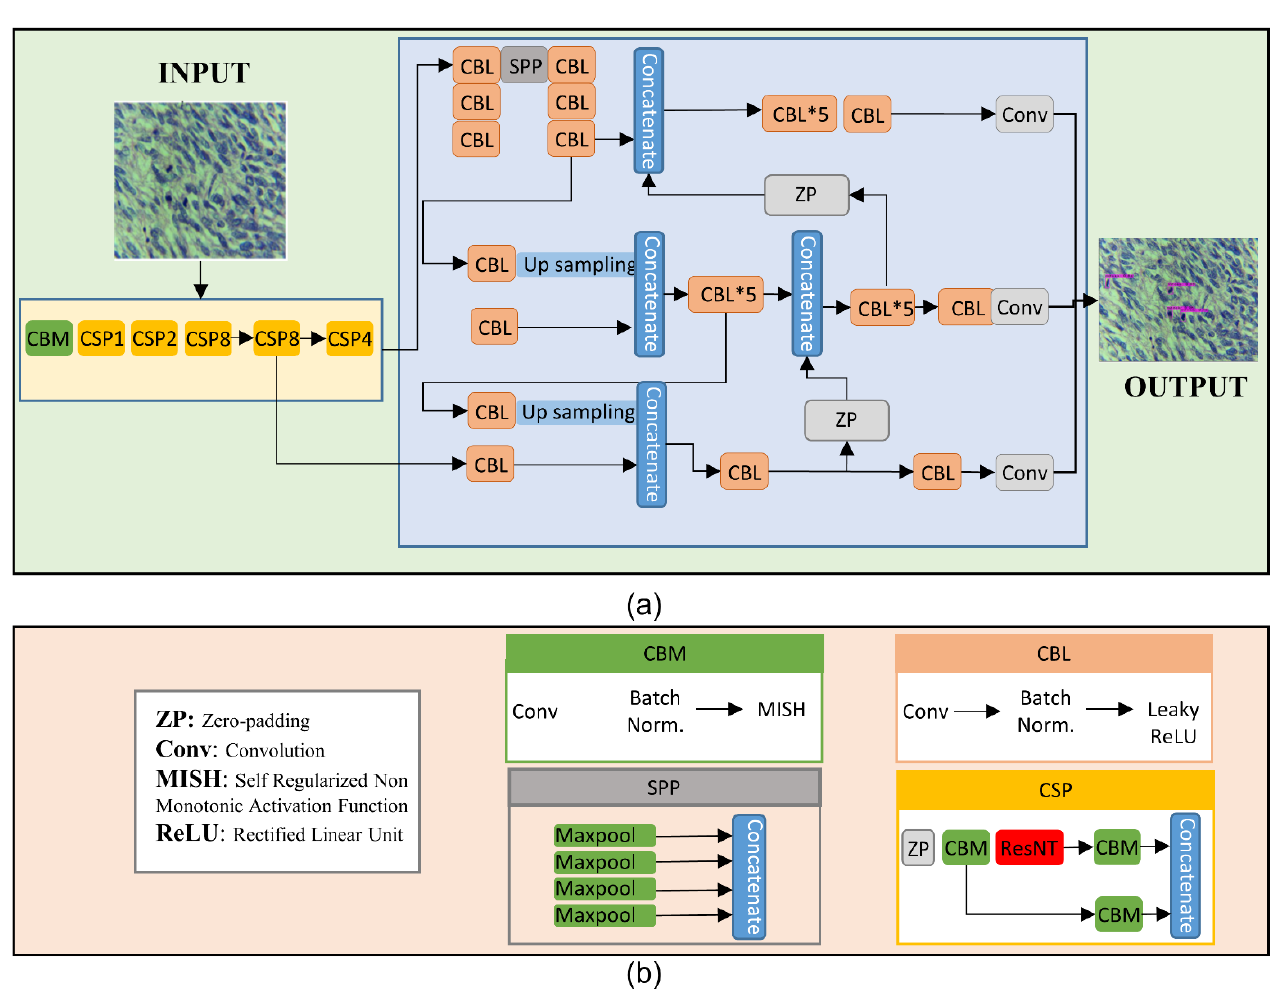
Figure 4. ( a ) The block diagram of opted deep-learning model showing the input image containing the mitotic regions, the deep learning chain, and the final output. ( b ) Structure of the sub-blocks used in ( a ).